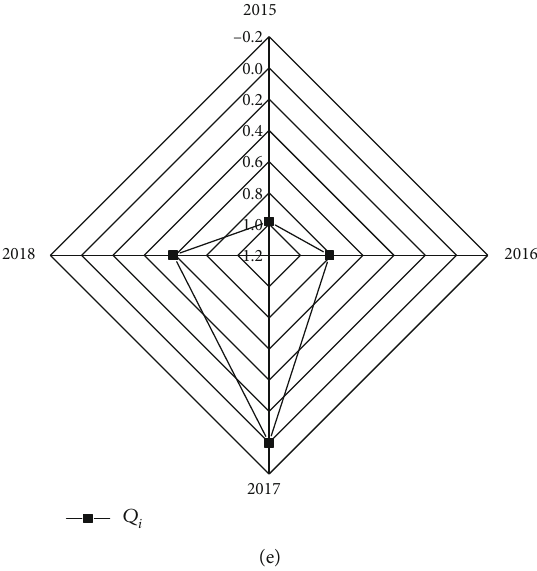
Figure 3: Comprehensive assessment results of water resource life cycle